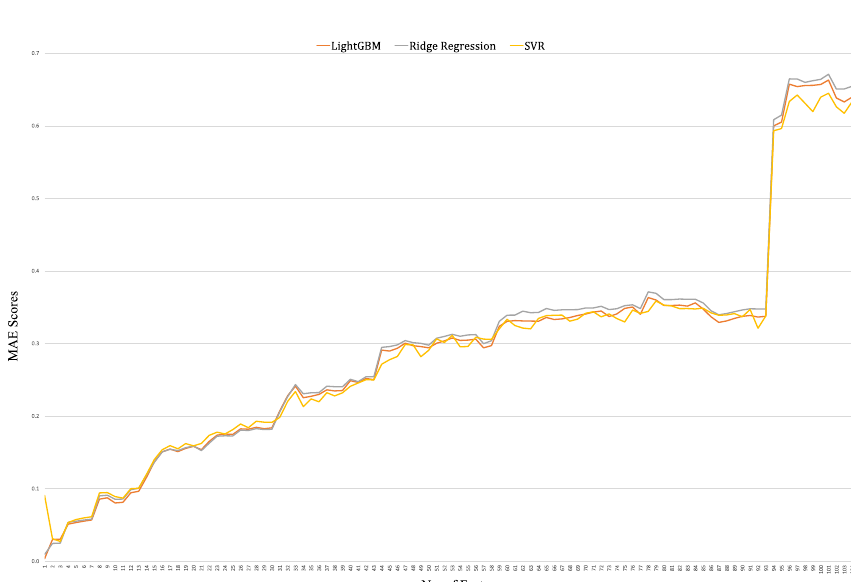
Fig. 7 Performance analysis of the wGRS sets